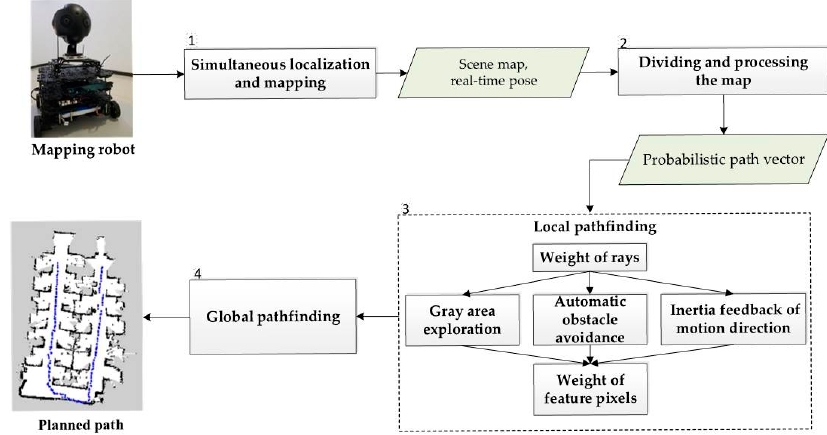
Figure 1. Overview of the eight-direction scanning detection algorithm.